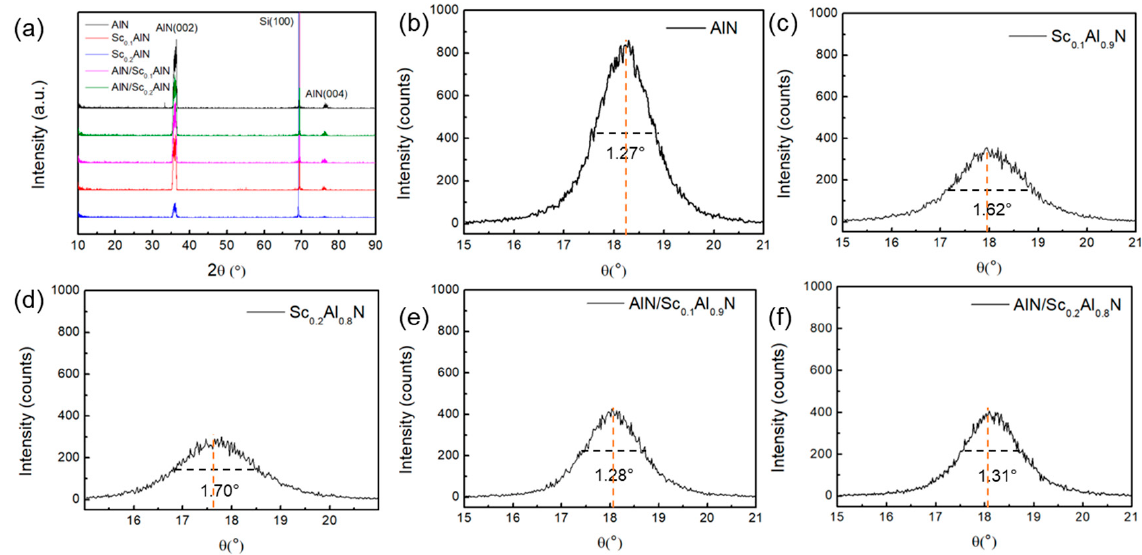
Figure 3. The XRD of AlN, ScAlN, and AlN/ScAlN composite films: ( a ) the θ -2 θ pattern of five types of films and FWHM of ( b ) AlN, ( c ) Sc 0.1 Al 0.9 N, ( d ) Sc 0.2 Al 0.8 N, ( e ) AlN/Sc 0.1 Al 0.9 N, ( f )AlN/ Sc 0.2 Al 0.8 N.